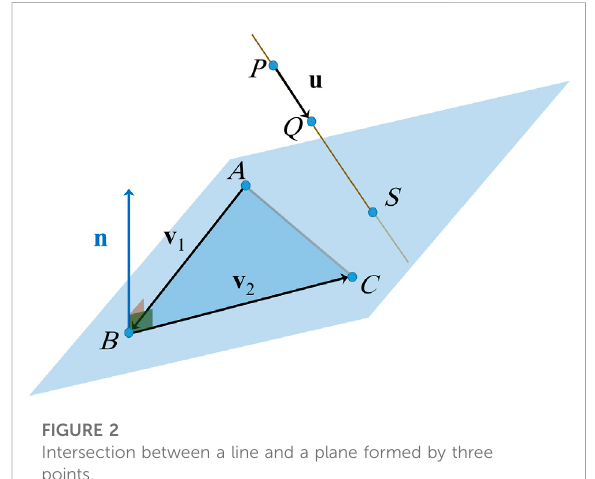
FIGURE 2 Intersection between a line and a plane formed by three points.